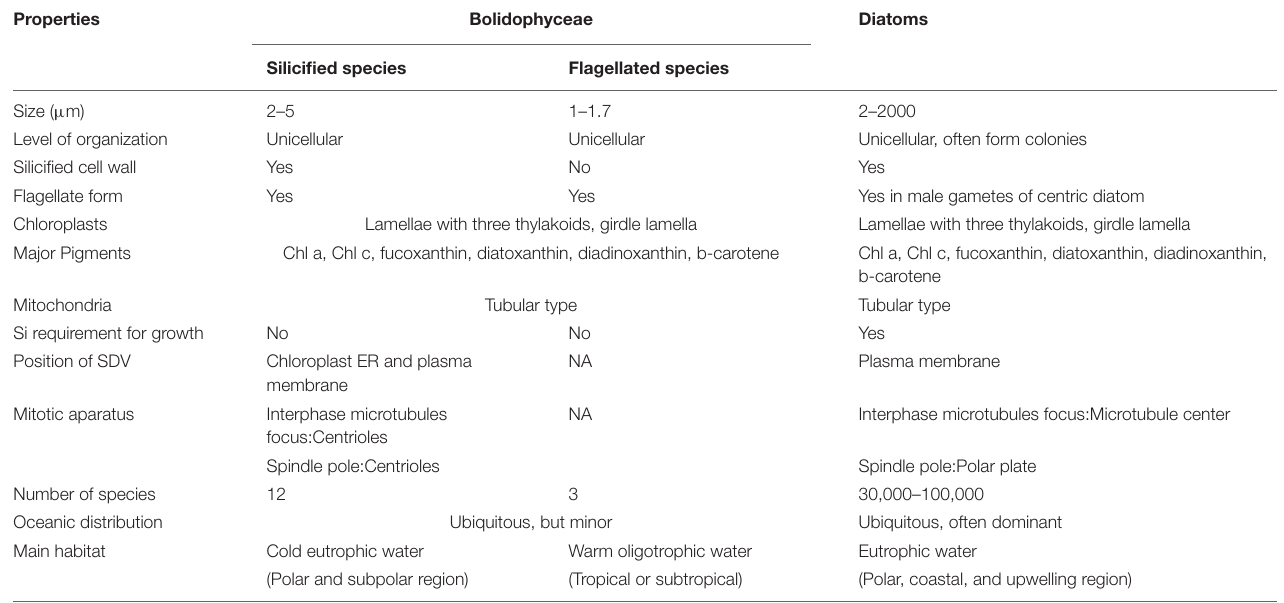
TABLE 4 | Comparison of selected characters between Bolidophyceae and diatoms.